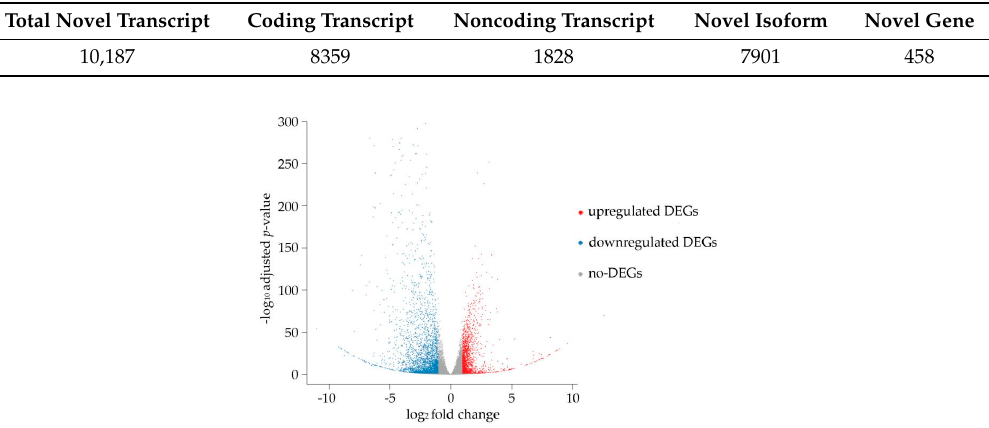
Table 2. Statistical data for RNA sequencing.